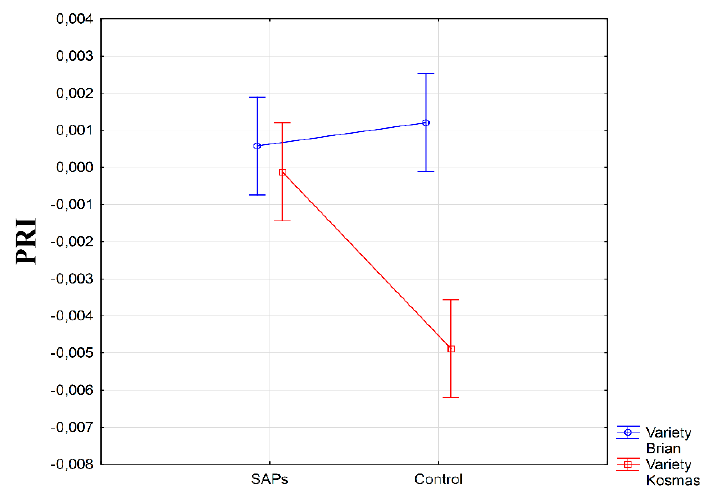
Figure 7. Interaction between experimental treatments and varieties for photochemical reflectance index (PRI). Figure was obtained at level of significance α = 0.01.